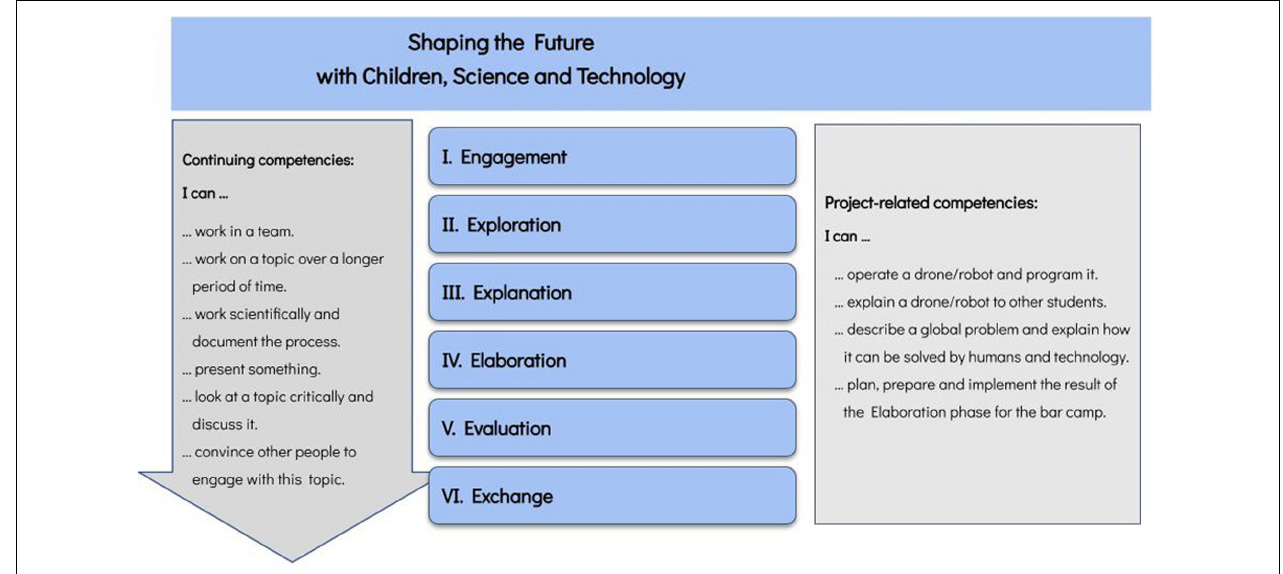
FIGURE 1 | Advanced organizer used in the project to show the students the competencies they can acquire.